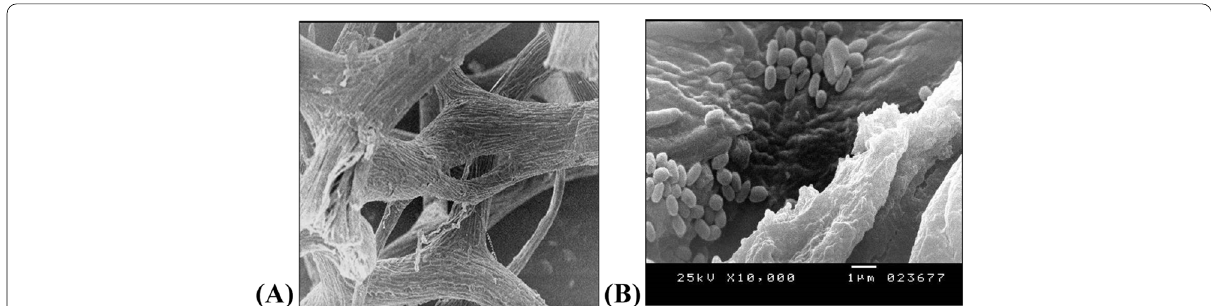
Fig. 5 Electron microscope micrographs showing the structure of luffa pulp ( A ). The density of cells of B. subtilis AAK adsorbed on the surface of luffa pulp surface ( B )